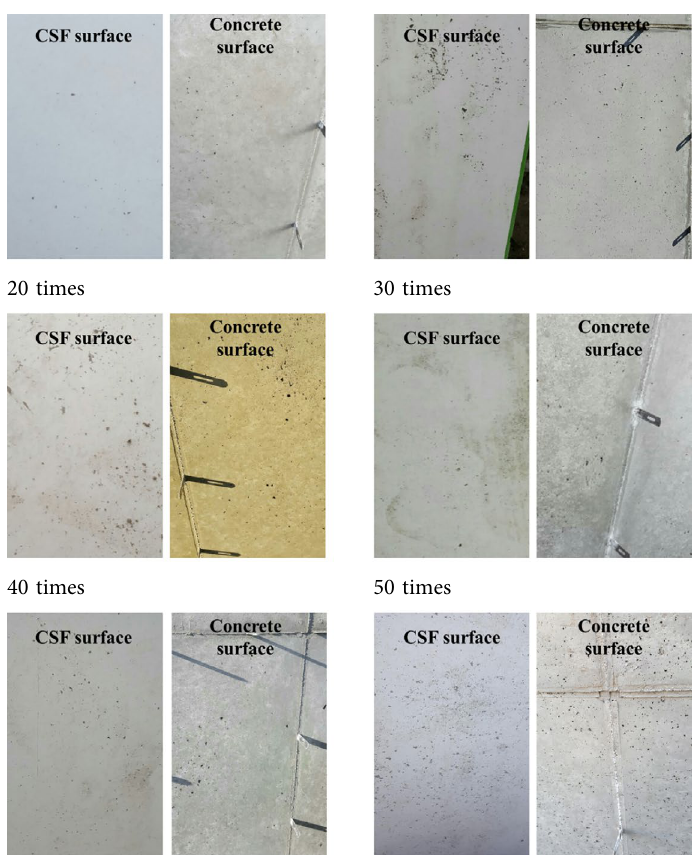
Figure 9. Concrete surface and formwork surface